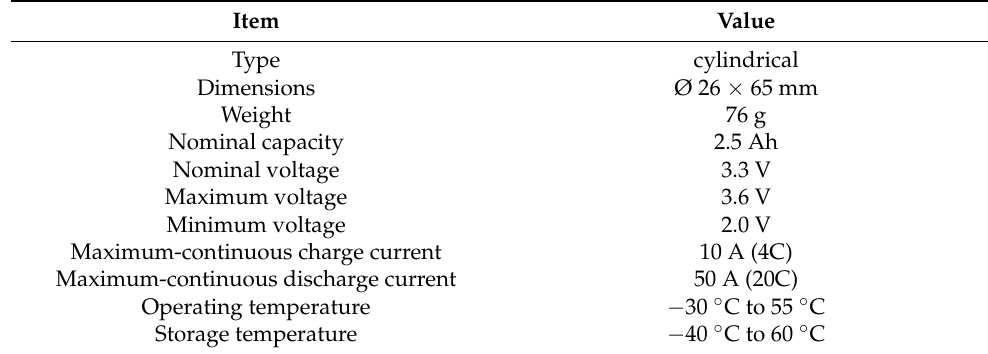
Table 1. Main electrical parameters of the tested LiFePO 4 /C battery